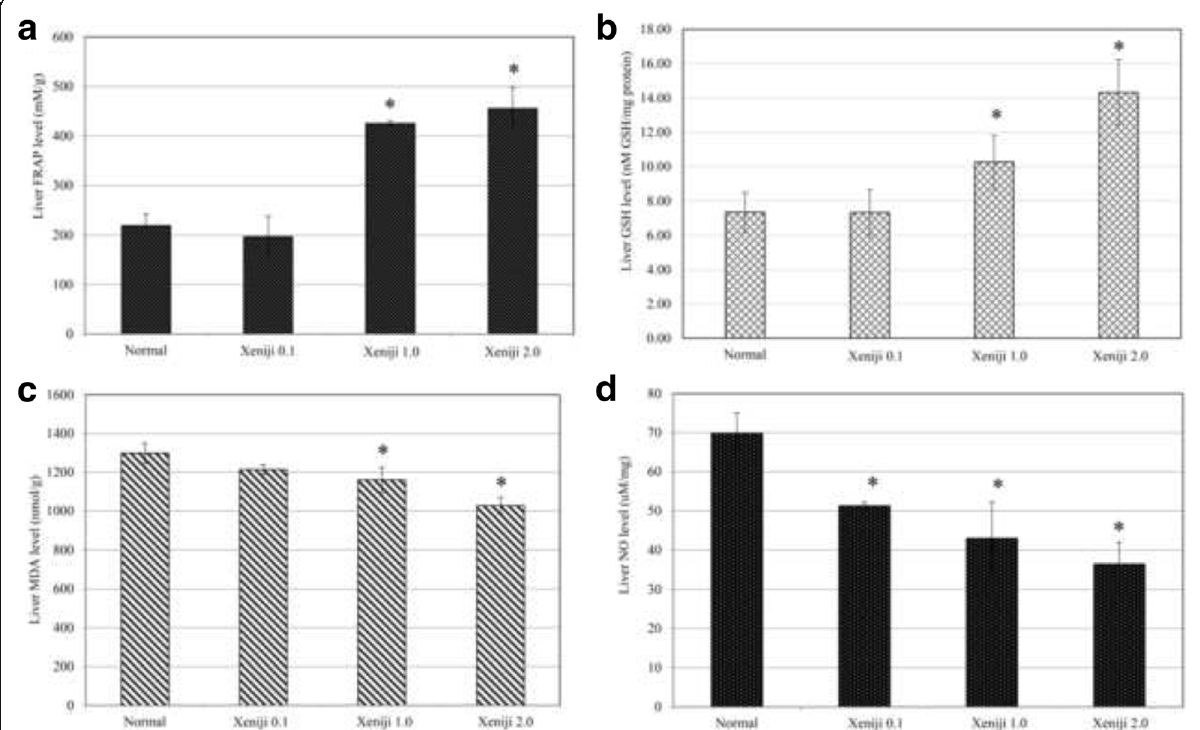
Fig. 2 a Total antioxidant capacity by quantified FRAP level; b GSH level; c lipid peroxidation MDA level and d NO level in liver of normal and Xeniji (0.1, 1 and 2 g/kg body weight) treated mice. *indicates a significant difference compared with the normal control group, p < 0.05